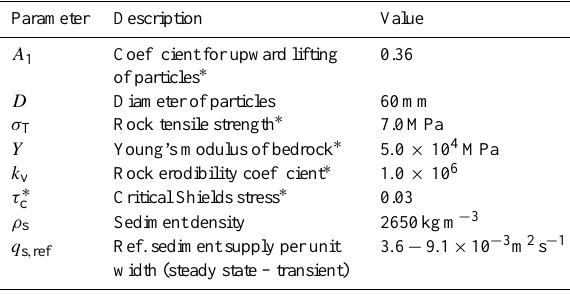
Table 2. Summary of parameter values for the saltation (Sect. 2.2.1) and total load (Sect. 2.2.2) erosion